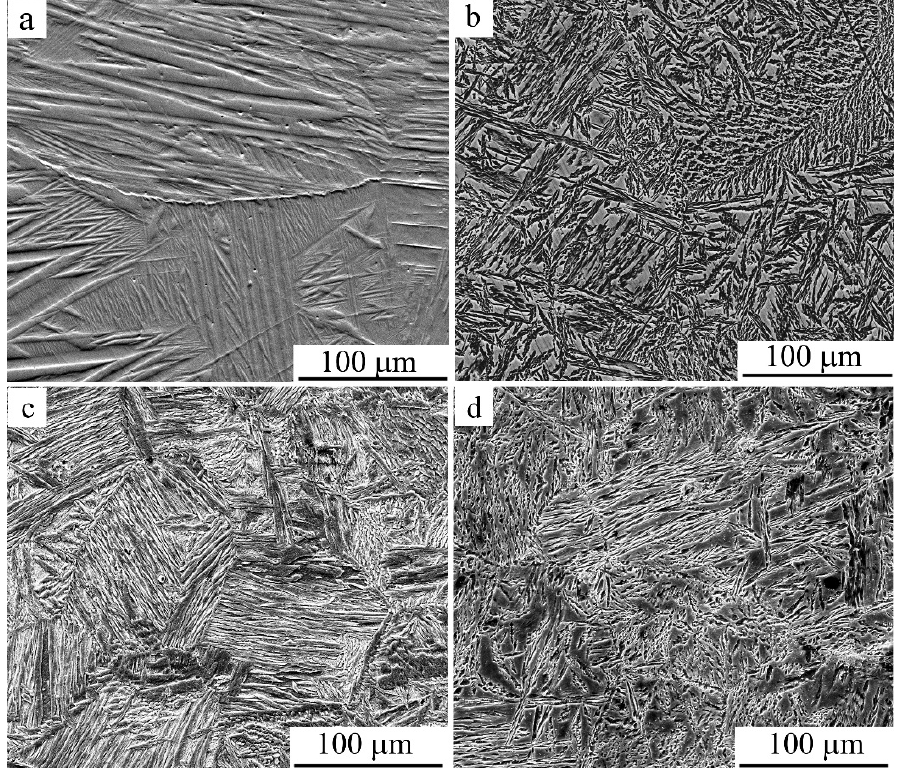
Figure 3. Secondary electron SEM images of the deformation-induced martensite in the Cu-14Al-4Ni alloy after ( a ) tensile tests or ( b – d ) compression tests at ( b ) RT and ( c , d ) 773 K (( c )— v = 5 mm/min, ( a , b , d )— v = 1 mm/min).